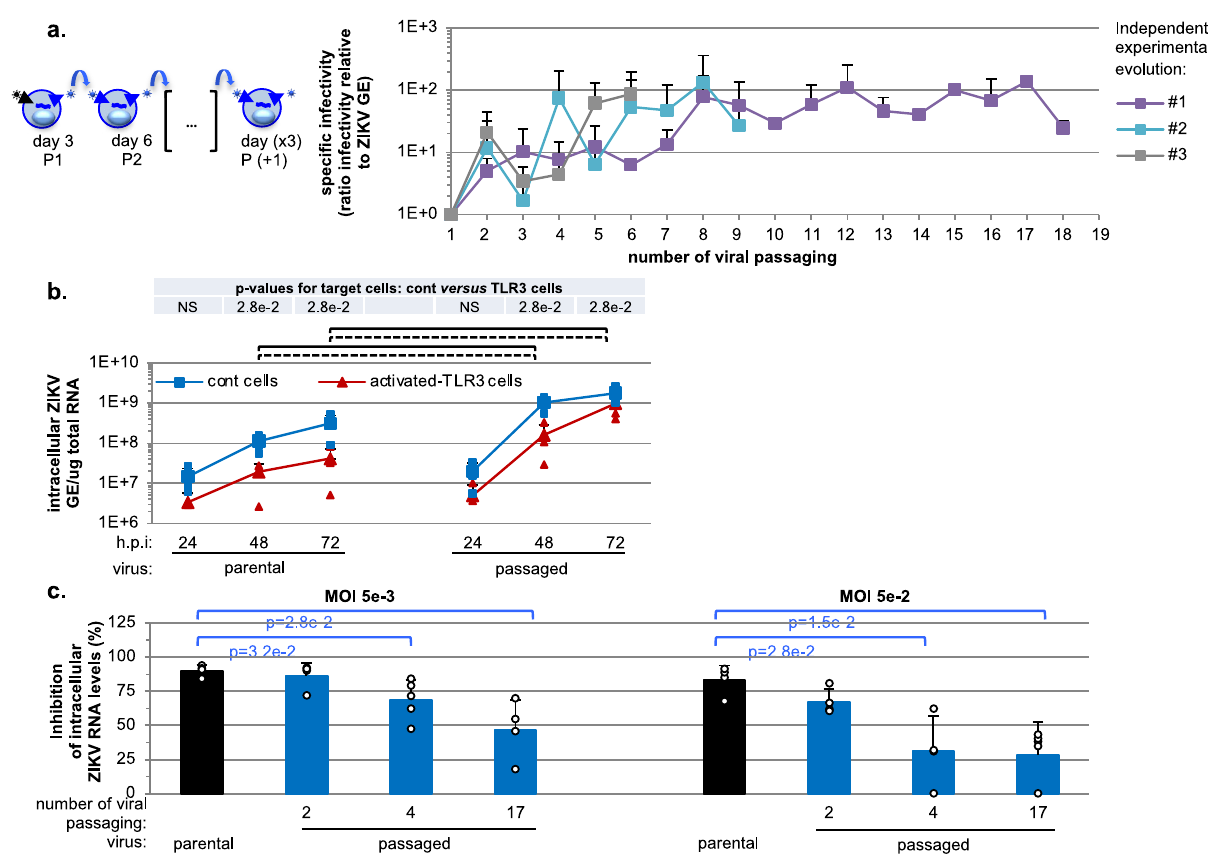
Fig. 1 Increased speci fi c infectivity and resistance to TLR3-mediated inhibition of serially passaged viral populations. a As shown on the schematic representation of the experimental procedure for serial passaging of ZIKV viral populations: every 3 days, viral supernatants were harvested, infectivity levels determined and, accordingly, used to infect naïve cells. Quanti fi cation of the speci fi c infectivity (i.e., de fi ned as the probability for one physical virion to initiate infection) of the viral populations harvested over serially passaging in the course of 3 independent runs of experimental evolution (referred to as #1, #2, #3 and stopped at passages 18, 7, and 6 respectively). Results are expressed as the ratio of the extracellular infectivity levels relative to extracellular ZIKV RNA levels and relative to passage 1 for each independent passaging in control cells set to 1; 2-to-3 independent determinations by RT-qPCR and infectious titrations for each evolution experiment; mean ± SD. b Quanti fi cation of the intracellular ZIKV genome levels in kinetic analysis of serially passaged viral populations obtained at passage 17 of the viral passaging versus parental virus assessed in activated-TLR3 cells (dotted lines) as compared to control cells (solid lines); at the indicated times post-infection at MOI 0.05; 4 independent experiments; mean ± SD. The statistical comparison of intracellular ZIKV GE levels for the same viral population at the same time point post-infection between activated-TLR3 and control cells is performed using a one-way ANOVA on ranks (Kruskal − Wallis test), as in ref. 31 . When the test was considered signi fi cant ( p -values ≤ 0.05), we used the Tukey Kramer (Nemenyi) pairwise test as post hoc test for pairwise comparisons of mean rank sums to determine which contrasts between individual experimental condition pairs were signi fi cant. The p -values from the Tukey Kramer (Nemenyi) pairwise tests are indicated in the table at the top of the graphs, when p < 0.05. The intracellular ZIKV GE levels at a same time post-infection between parental and passaged virus similarly determined as signi fi cantly different ( p < 0.05) are indicated by brackets: dotted lines for the comparison of levels in activated-TLR3 cells and solid lines for the comparison of levels in control cells. c Inhibition by TLR3-signaling of replication of viral populations harvested at the indicated times of the serial passaging (i.e., passages 2, 4, and 17). Results represent the percentage of inhibition in activated-TLR3 cells relative to control cells of intracellular ZIKV genome levels determined at 3 days post- infection at MOI 5e -3 (left panel) and 5e -2 (right panel); 4 independent experiments; mean ± SD; signi fi cant differences ( p < 0.05) are indicated by the brackets at the top of the